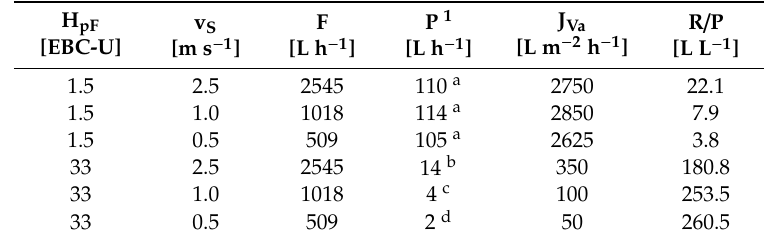
Table 2. E ff ect of feed permanent haze (H pF ) and superficial velocity (v s ), or feed flow rate (F), on the permeate flow rate (P), average permeation flux (J Va ), and recirculation ratio (R / P) when operating at 30 ◦ C with 1.4- µ m ceramic HF membrane module under the operating conditions given in the text.